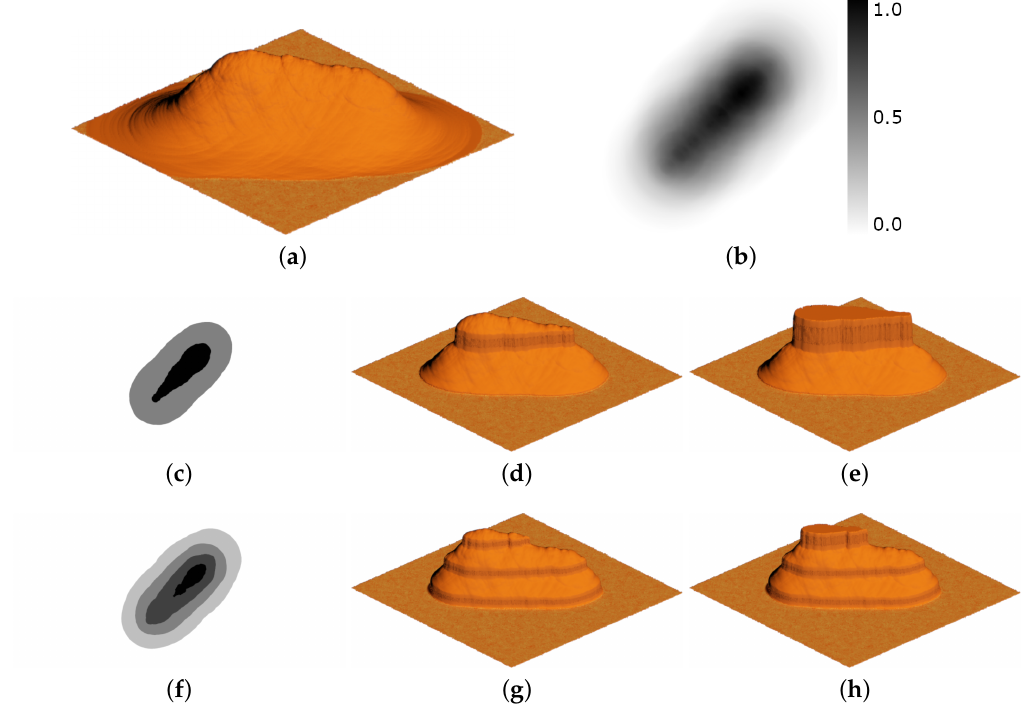
Figure 14. Sample butte generated by circular faults limited along the x-axis (grid resolution: 1024 × 1024; fault radius: 1 (cid:54) r (cid:54) 350; total faults: 250). Erosive model was obtained for E = 0.45 and ρ = 5. ( a ) Initial geometry. ( b ) Initial map. ( c ) Material layer ( mat = 3) interpreted as a grey-scale map. ( d ) mat = 3 without caprock. ( e ) mat = 3 with caprock. ( f ) Material layer ( mat = 5) interpreted as a grey-scale map. ( g ) mat = 5 without caprock. ( h ) mat = 5 with caprock.